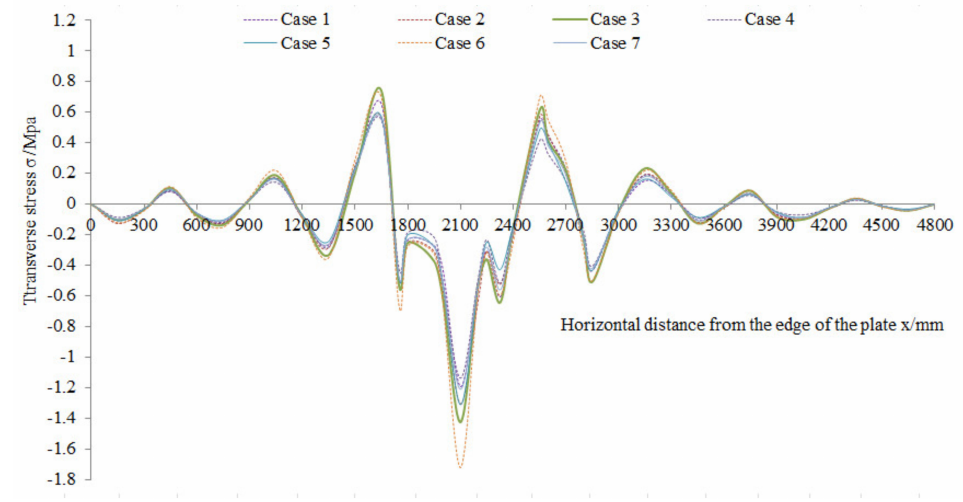
Figure 11. Comparison of transverse tensile stress distribution of the pavement under different schemes under load